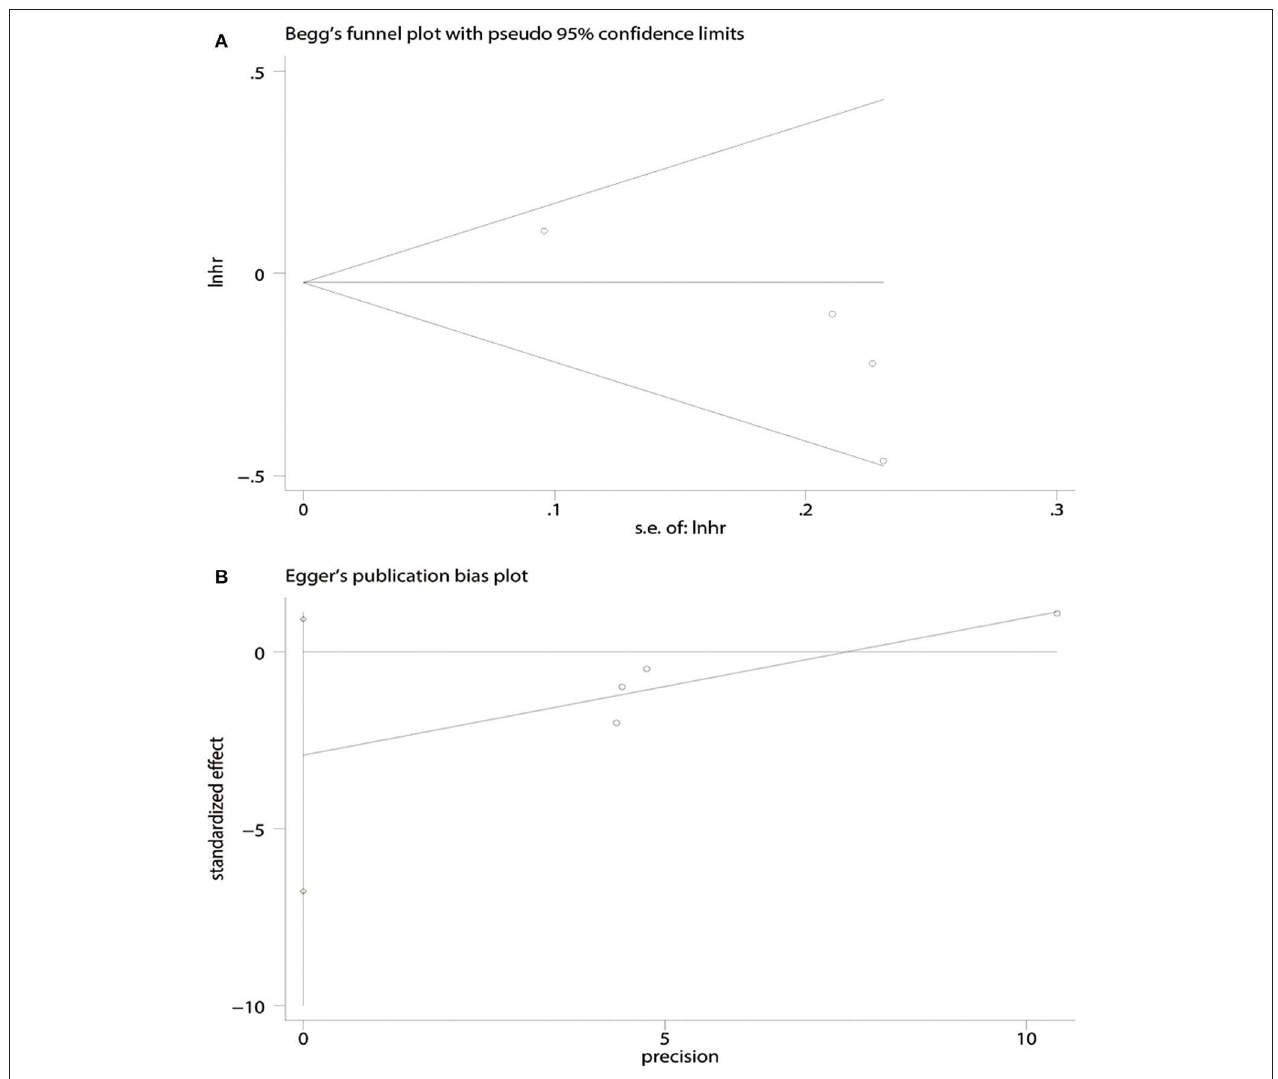
FIGURE 5 | Publication bias in terms of progression-free survival (PFS) analysis. (A) Begg’s test. (B) Egger’s test.